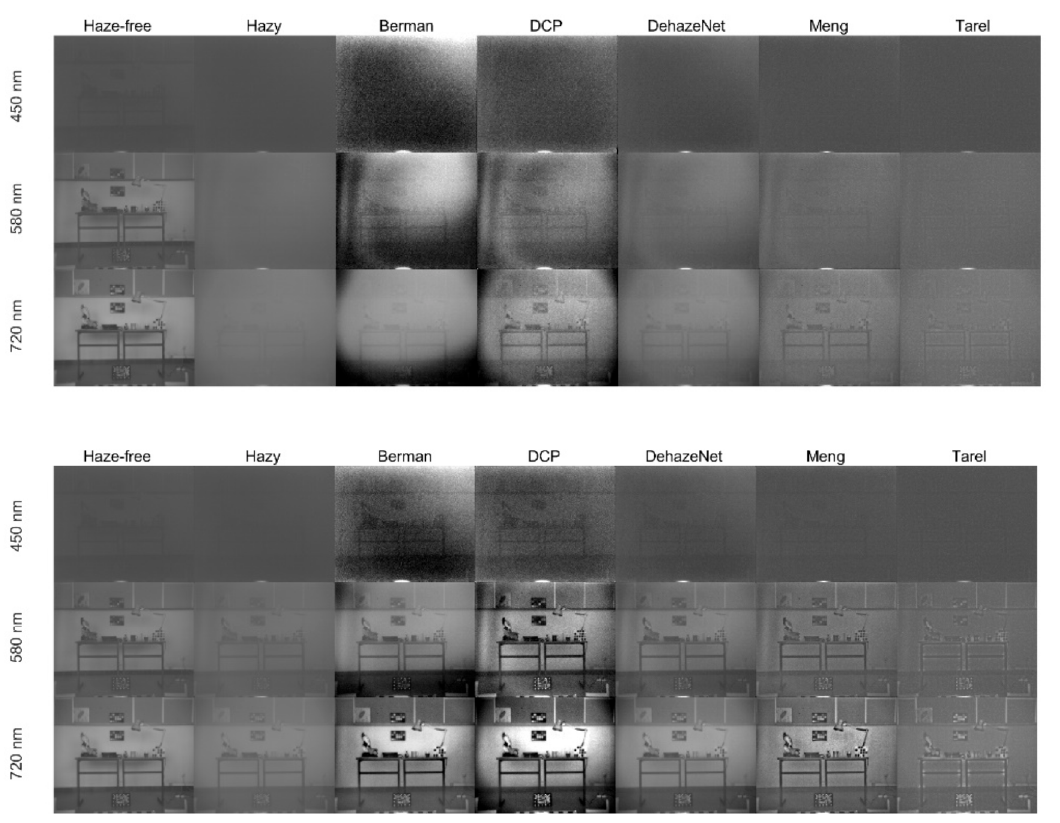
Figure 3. Original haze-free (first column), hazy (second column) and dehazed (columns 3 to 7) images for wavelength 450 nm (first row), 580 nm (second row) and 720 nm (third row). The images correspond to low haze conditions (upper figure) and high haze conditions (lower figure).